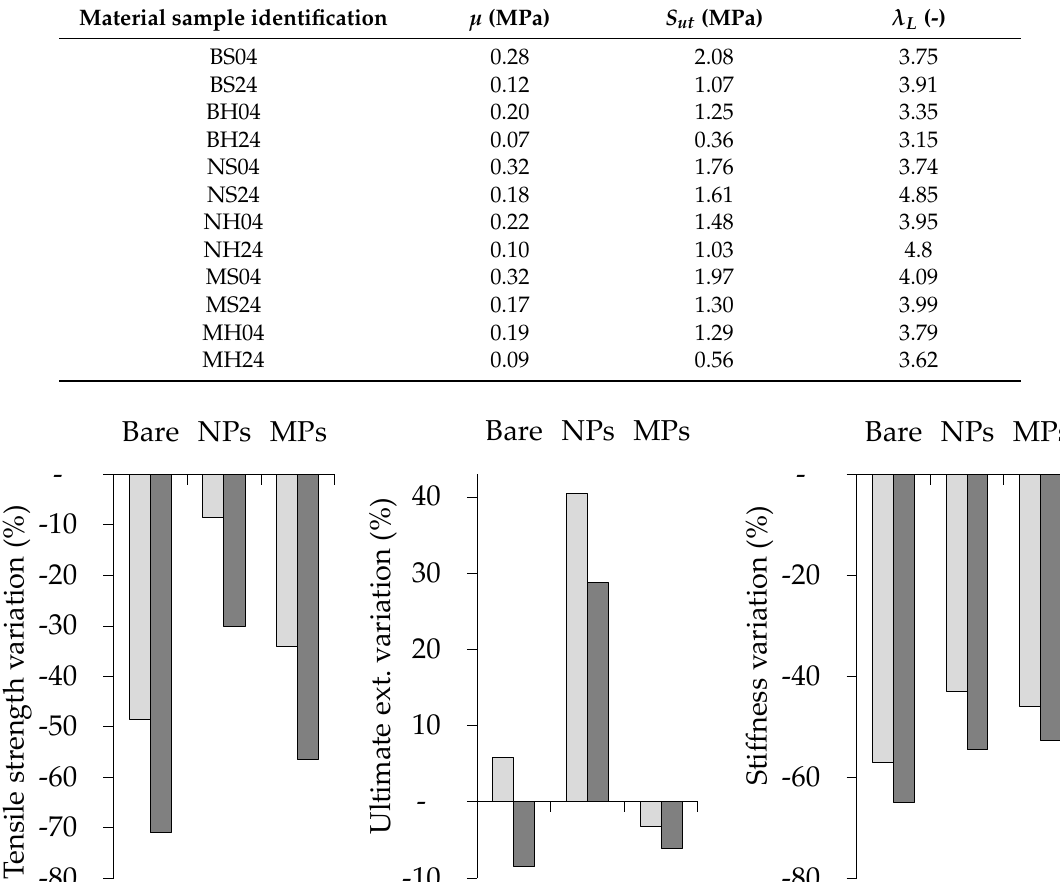
Table 2. Shear modulus µ , tensile strength ( S ut ) and the elongation at break ( λ L ) obtained from uniaxial tensile tests.